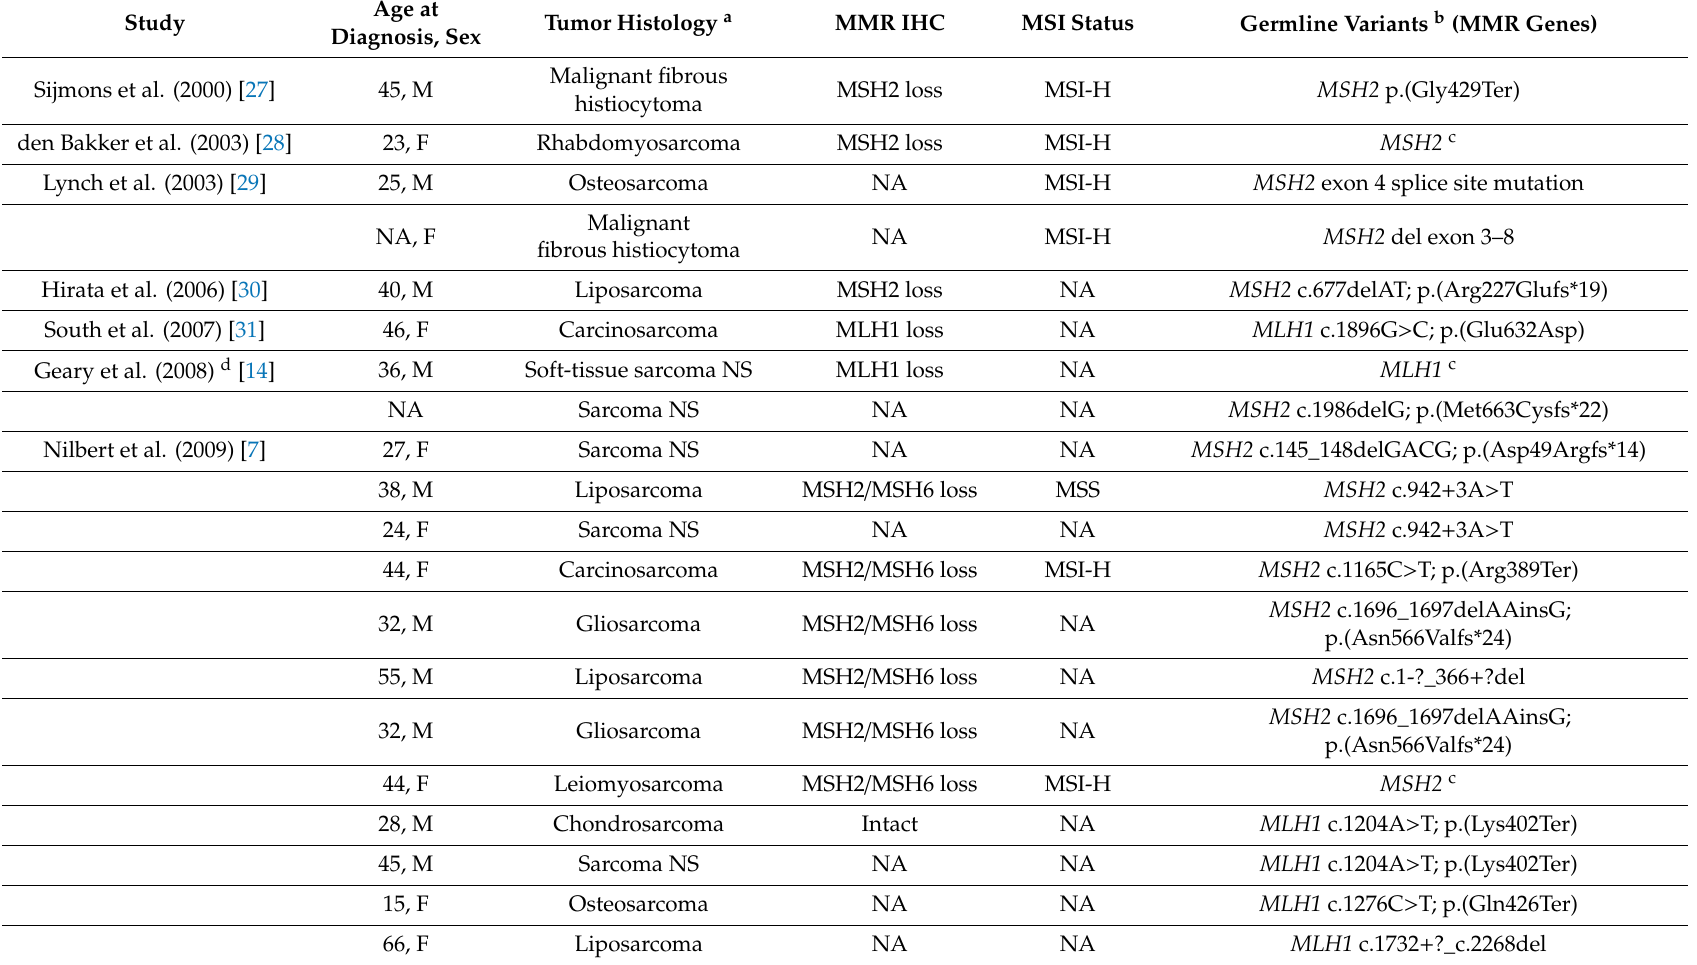
Table 2. Clinical and molecular features of sarcoma cases in LS patients from literature